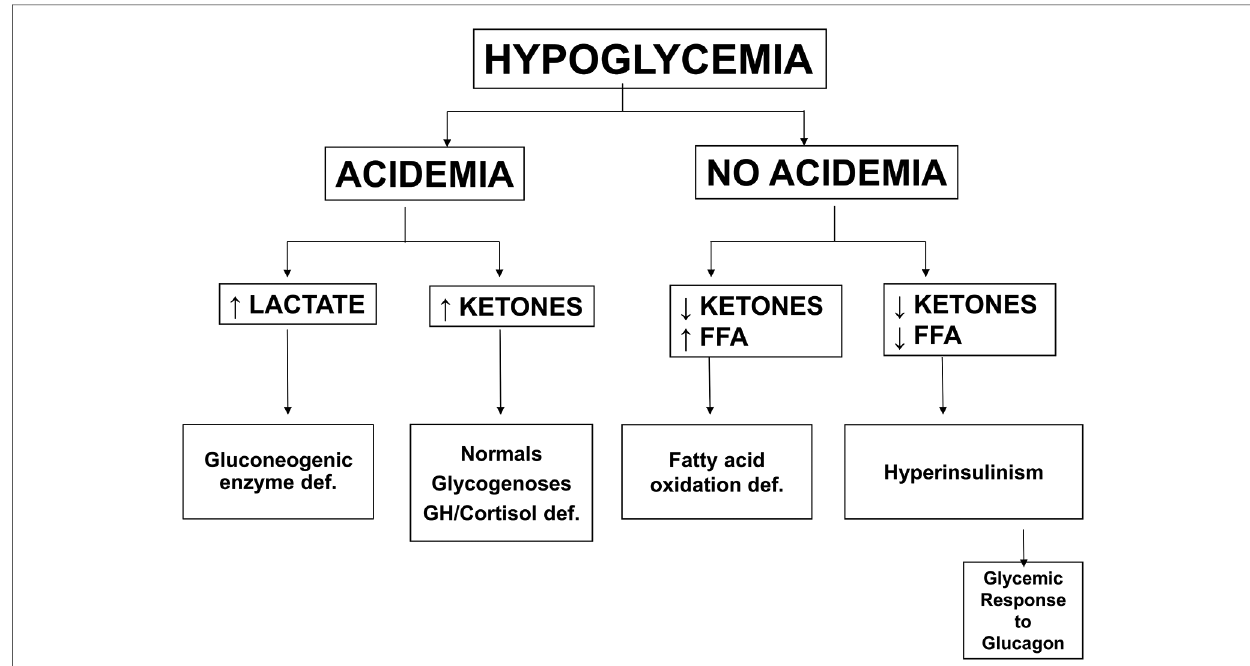
FIGURE 3 Differential diagnosis of hypoglycemia based on plasma metabolic fuel responses. Note that Hyperinsulinism is associated with suppression of ketones and FFA and retention of a large glycemic response to injection of glucagon. Abbreviations: FFA (free fatty acids), GH/Cortisol def (growth hormone and/ or cortisol de fi